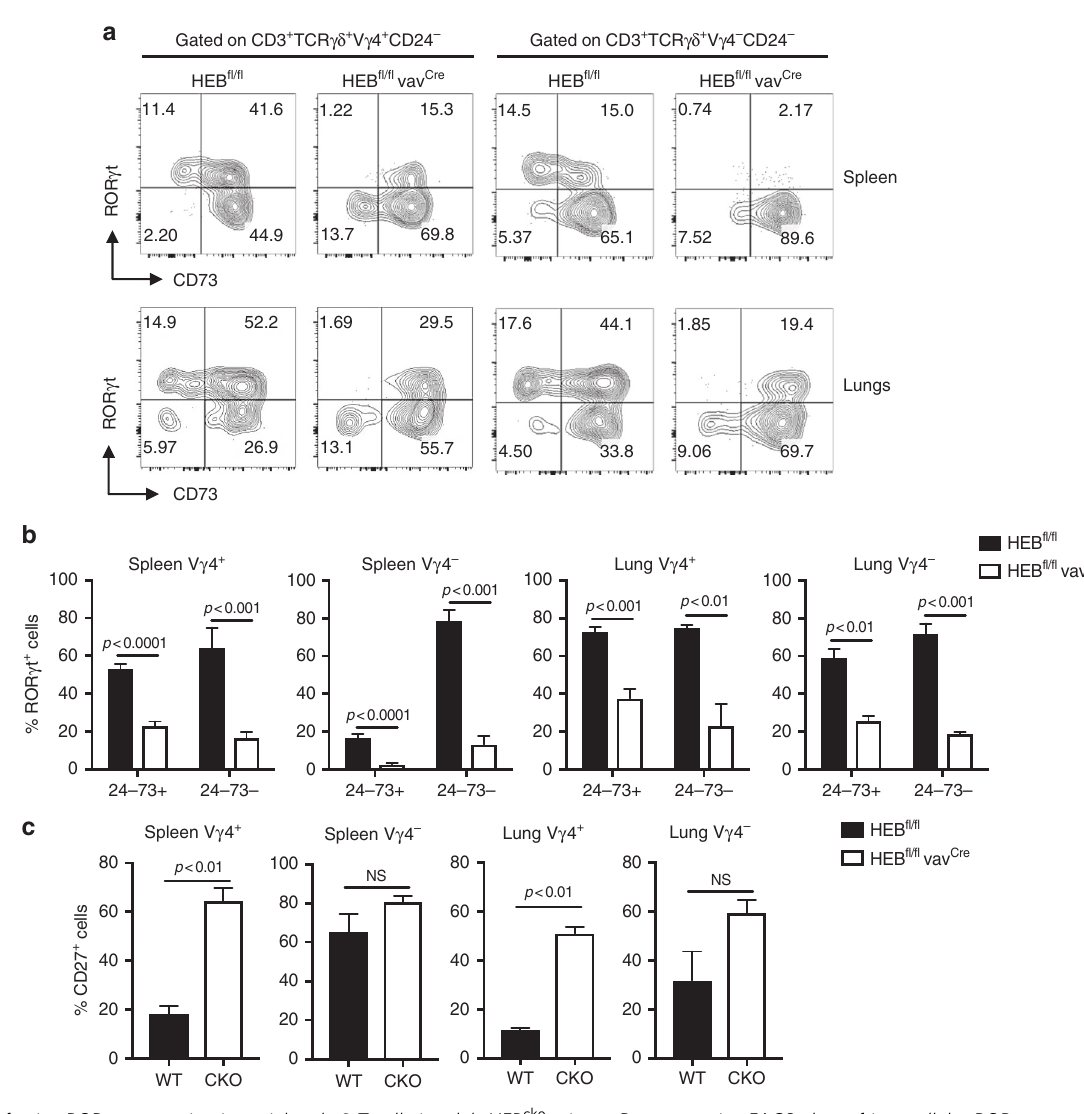
Fig. 8 Defective ROR γ t expression in peripheral γδ T cells in adult HEB cko mice. a Representative FACS plots of intracellular ROR γ t vs. surface CD73 expression in mature V γ 4 + and V γ 4 − γδ T cells (CD24 − CD3 + TCR γδ + ) in the spleen and lungs of HEB fl / fl (WT) and HEB fl / fl vav Cre mice. Numbers in FACS plots indicate frequencies within each gate. b Quanti fi cation of the frequencies of ROR γ t + cells within CD24 − CD73 + and CD24 − CD73 − populations in V γ 4 + and V γ 4 − γδ T cells from the spleen and lungs of HEB fl / fl and HEB fl / fl vav Cre mice. c Quanti fi cation of the frequencies of CD27 + cells within V γ 4 + and V γ 4 − γδ T cells in the spleen and lungs of HEB fl / fl and HEB fl / fl vav Cre mice, as determined by fl ow cytometry. All plots were gated on CD3 + TCR γδ + cells. Data are representative of at least two independent experiments with 3 mice per group. Center values indicate mean, error bars denote s.e.m. p -values were determined by two tailed Student's t- test. NS = not signi fi